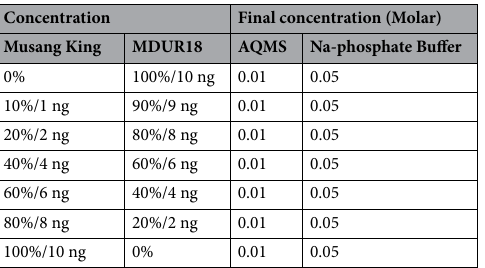
Table 4. Combination of MK and MDUR88 gDNA used for the sensitivity test of biosensor